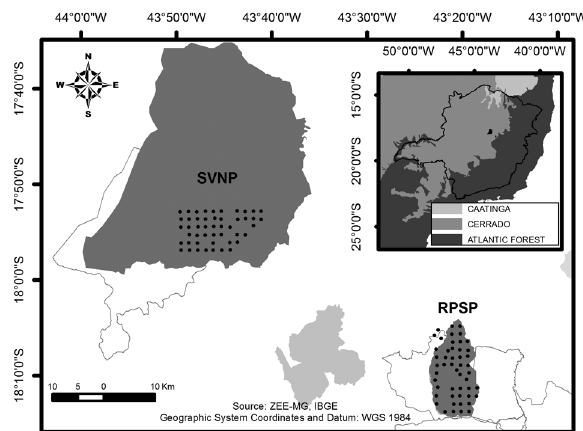
Figure 1. Camera trap sites (black circles) surveyed at Rio Preto State Park and Sempre Vivas National Park. Areas of integral protection in gray and areas of sustainable use in hollow